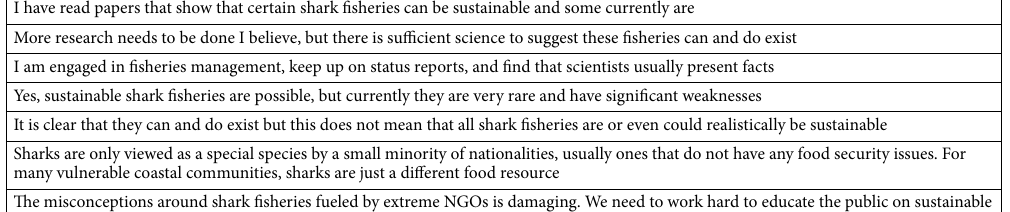
Table 2. Representative example responses showing reasons why respondents agree that sustainable shark fisheries are possible and